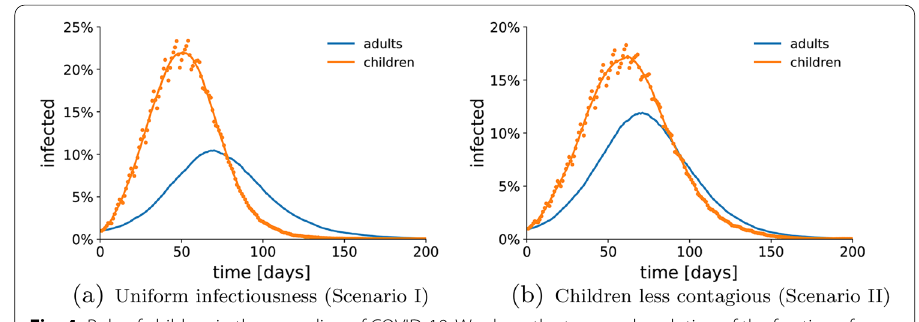
Fig. 4 Role of children in the spreading of COVID-19. We show the temporal evolution of the fraction of infections among the adults (blue dots) and children (orange dots) in a representative simulation, in the absence of vaccination V = 0 . The solid curves illustrate the 7-day moving average of the two quantities. In ( a ), we consider Scenario I (original strain, uniform contagion probability), in which all the individuals have the same per-contact infection probability; in ( b ), Scenario II (original strain, different contagion probability), in which children have a decreased per-contact infection probability. The parameters used in the simulations are listed in Table 2, q a = 0.25 , and q c = 0.12